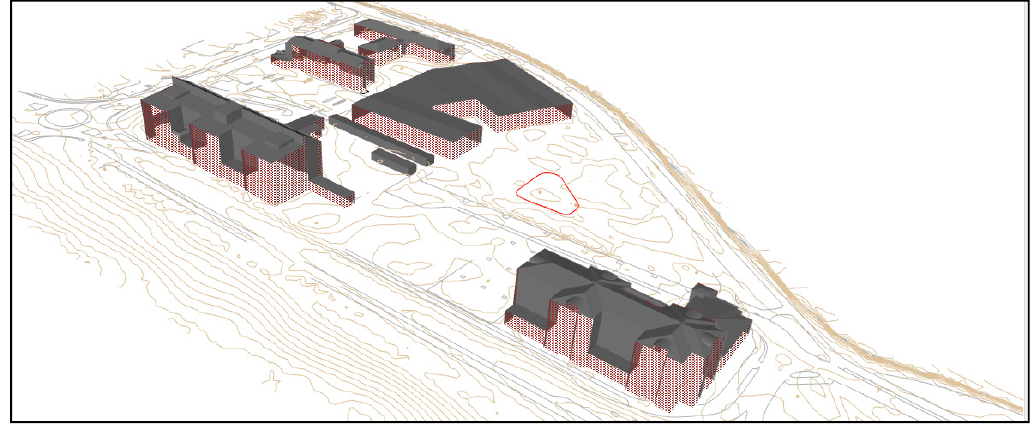
Figure 8. Existing buildings and a footprint of Lotsen on top of 3D contour lines.